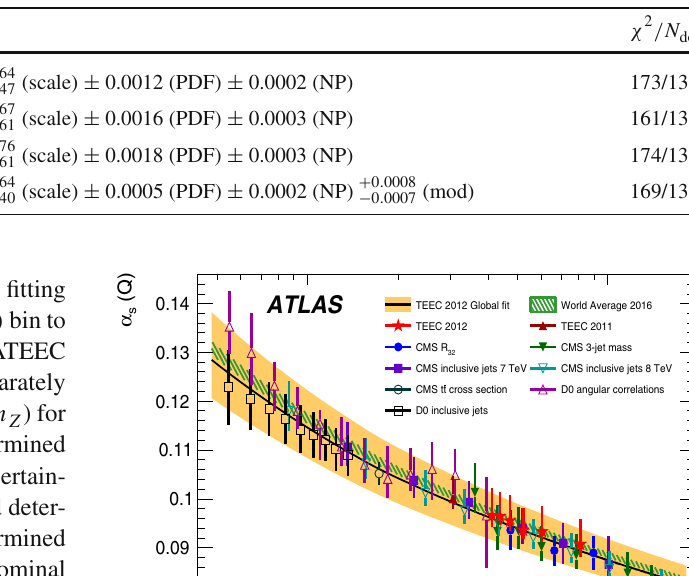
Table 4 The results for α s from fits to the TEEC using different PDFs. The uncertainty referred to as NP is the one related to the non-perturbative corrections. The uncertainty labelled as ‘mod’ corresponds to the HERAPDF modelling and parameterisation uncertainty